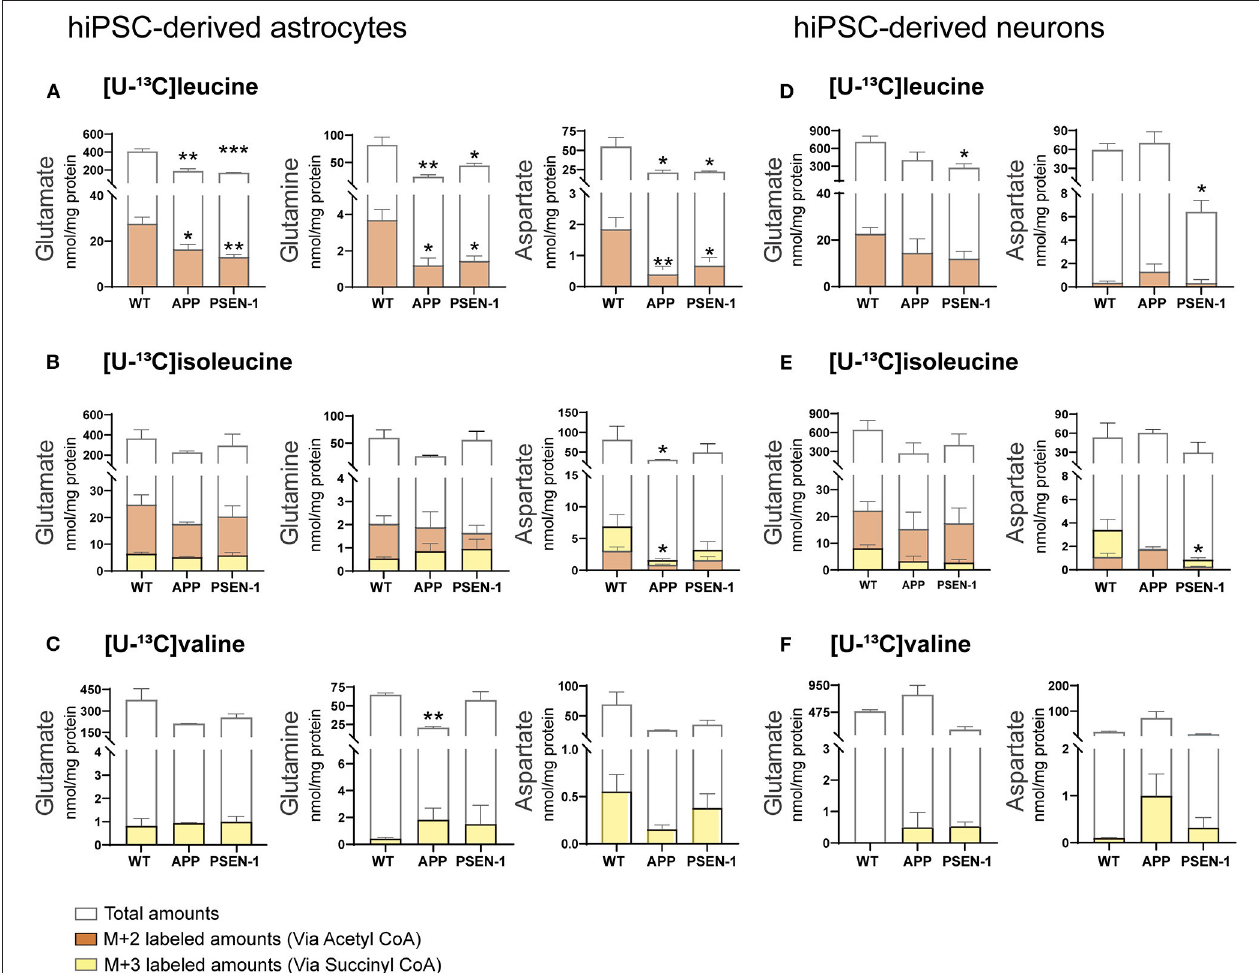
FIGURE 7 | Selective disruptions of amino acid amounts in AD astrocytes with APP and PSEN-1 mutations following incubation with [U- 13 C]leucine. (A) nmol/mg protein in M + 2 ( via acetyl CoA) labeling and total amounts after incubation with [U- 13 C]leucine. (B) nmol/mg protein in M + 2 ( via acetyl CoA) and M + 3 ( via succinyl CoA) labeling and total amounts after incubation with [U- 13 C]isoleucine. (C) nmol/mg protein in M + 3 ( via succinyl CoA) labeling and total amounts after incubation with [U- 13 C]valine in hiPSC-derived astrocytes. (D) nmol/mg protein in M + 2 ( via acetyl CoA) labeling and total amounts after incubation with [U- 13 C]leucine. (E) nmol/mg protein in M + 2 ( via acetyl CoA) and M + 3 ( via succinyl CoA) labeling and total amounts after incubation with [U- 13 C]isoleucine. (F) nmol/mg protein in M + 3 ( via succinyl CoA) labeling and total amounts after incubation with [U- 13 C]valine in hiPSC-derived neurons. Values represent mean ( ± ) SEM ( n = 3), * p < 0.05, ** p < 0.01, *** p < 0.001 when compared with control, analyzed by one-way ANOVA. No significant differences were found in M + 3 labeling amounts in AD astrocytes. WT, wild type; APP, amyloid precursor protein; PSEN-1, presenilin-1.